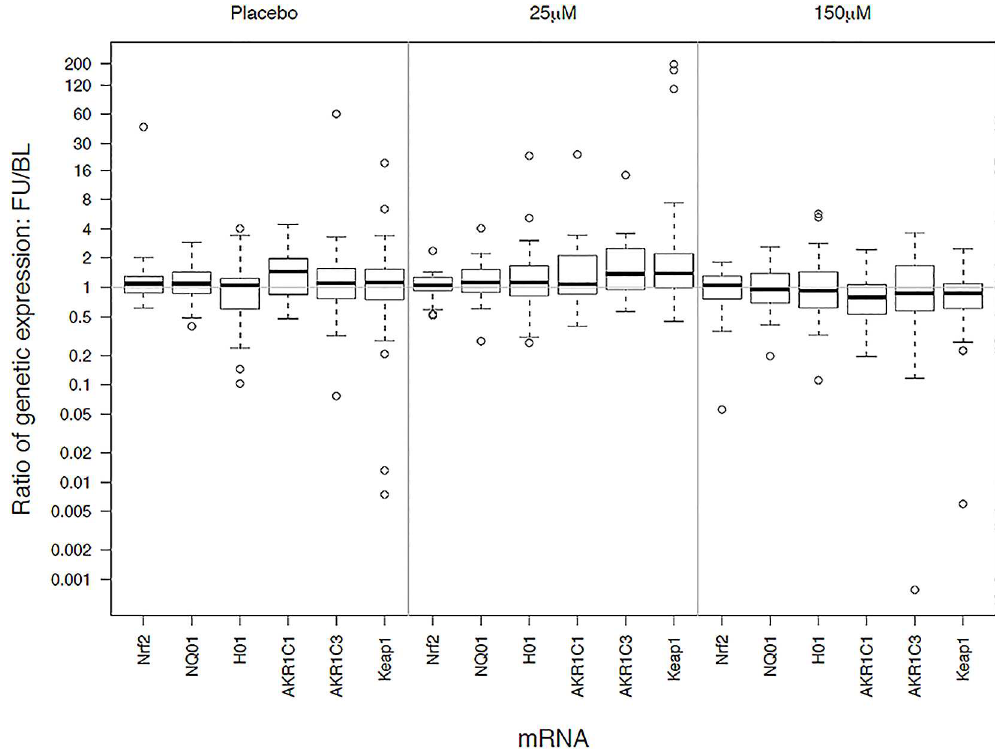
Fig 3. Relative changes in gene expression by treatment group in bronchial epithelial cells. Treatments are labeledas placebo(no sulforaphane), 25 μ M) and 150 μ M of sulforaphane.Gene identifiers are listed along the x- axis. The y-axis displaysthe distribution of fold-changein gene expression (follow-updividedby baseline).